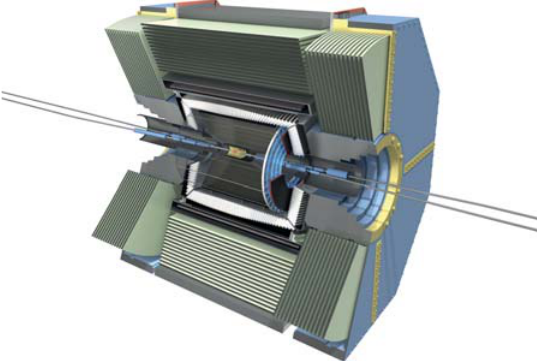
Figure 3. The Belle II